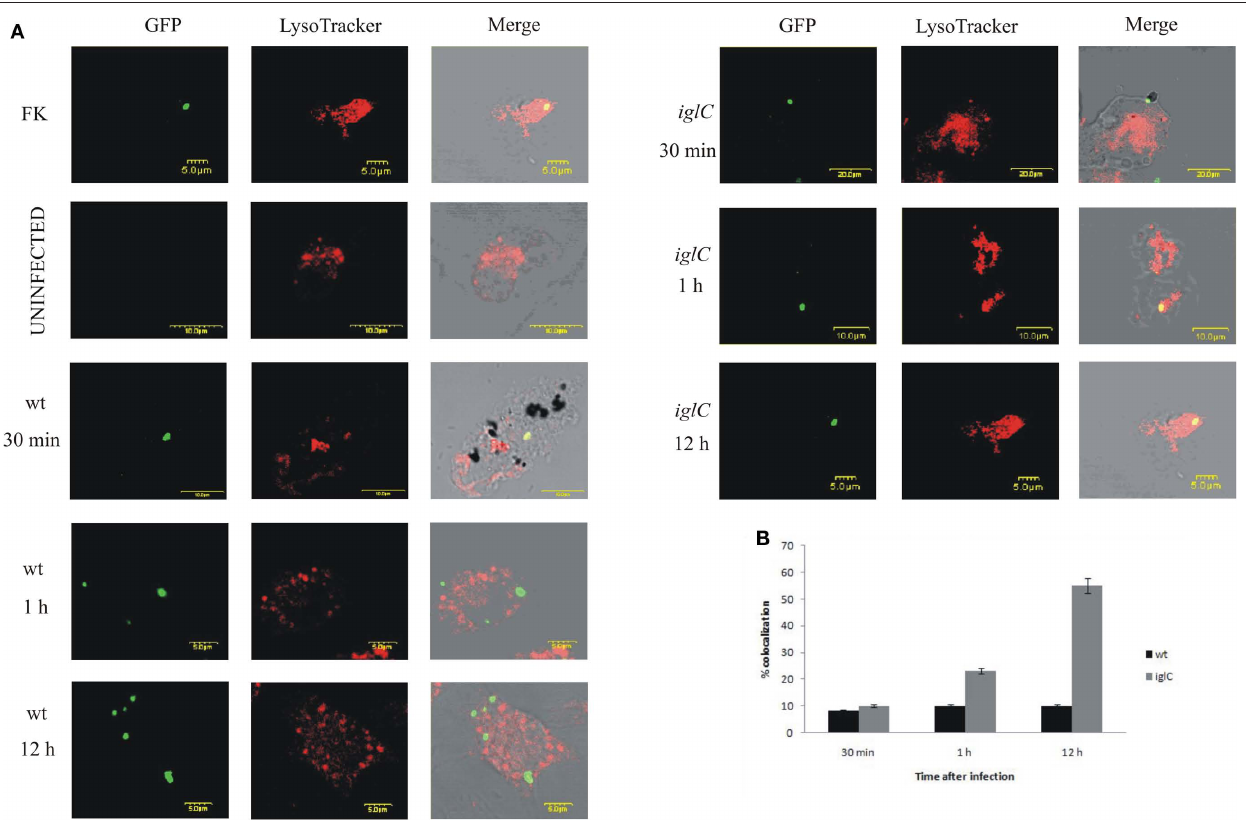
from three different cover slips. The results shown are representative of three independent experiments. (B) Quantification of colocalization of the LysoTracker DND-99 dye with the FCVs of the bacterium at 30 min, 1, and 12 h post-infection is shown. The results shown are representative of three independent experiments, and error bars represent standard deviations of